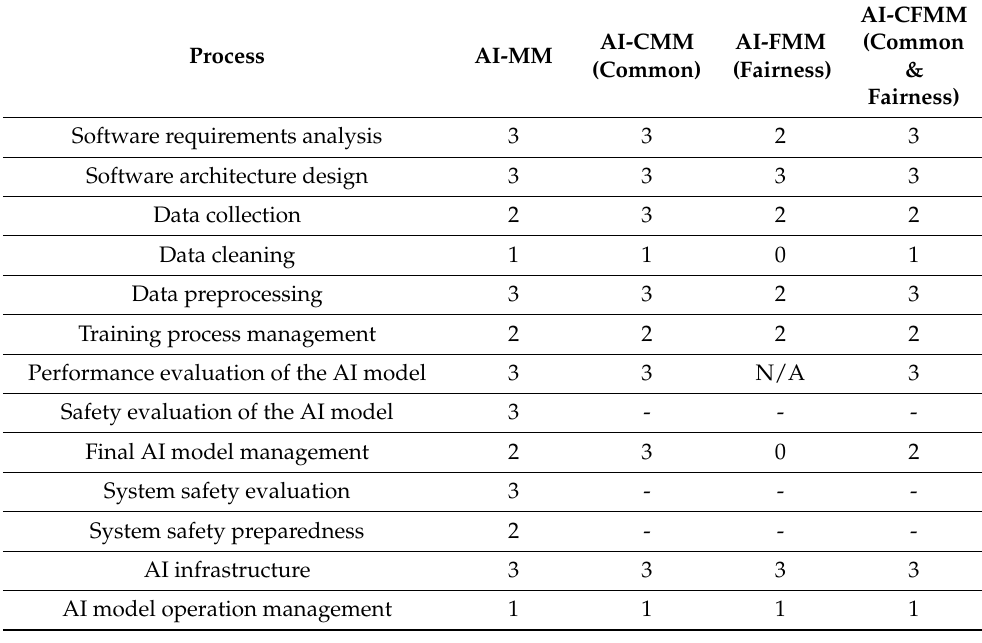
Table 12. Assessment results of language translation by AI-MM.